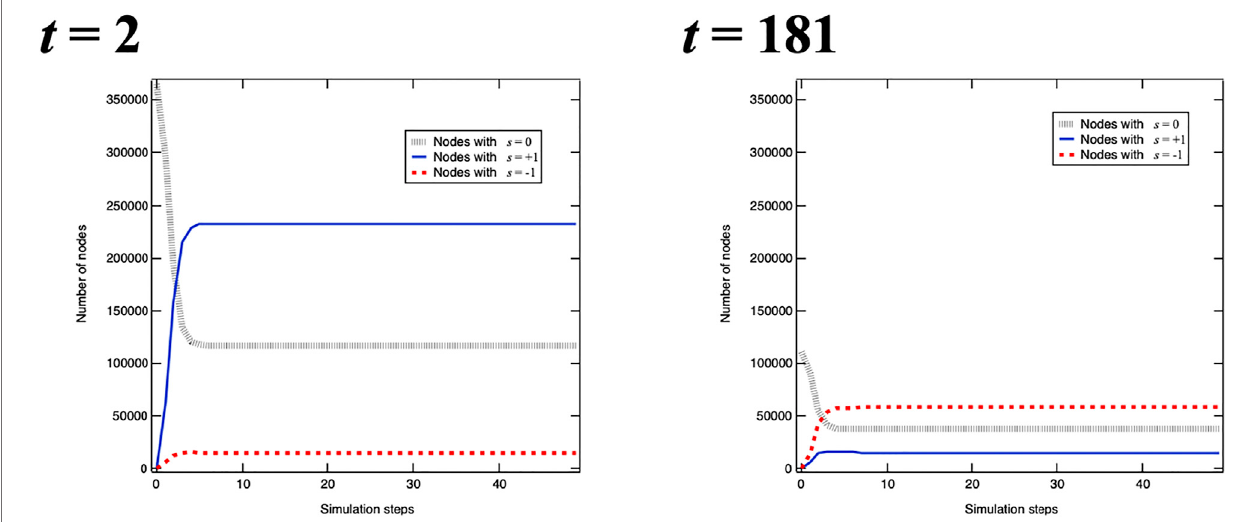
FIGURE 3 | Examples of simulations at step t . The vertical axis indicates the number of nodes as a function of simulation steps in the one simulation at t (cid:1) 2 and t (cid:1) 181. The number of nodes does not change after 50 simulation steps.